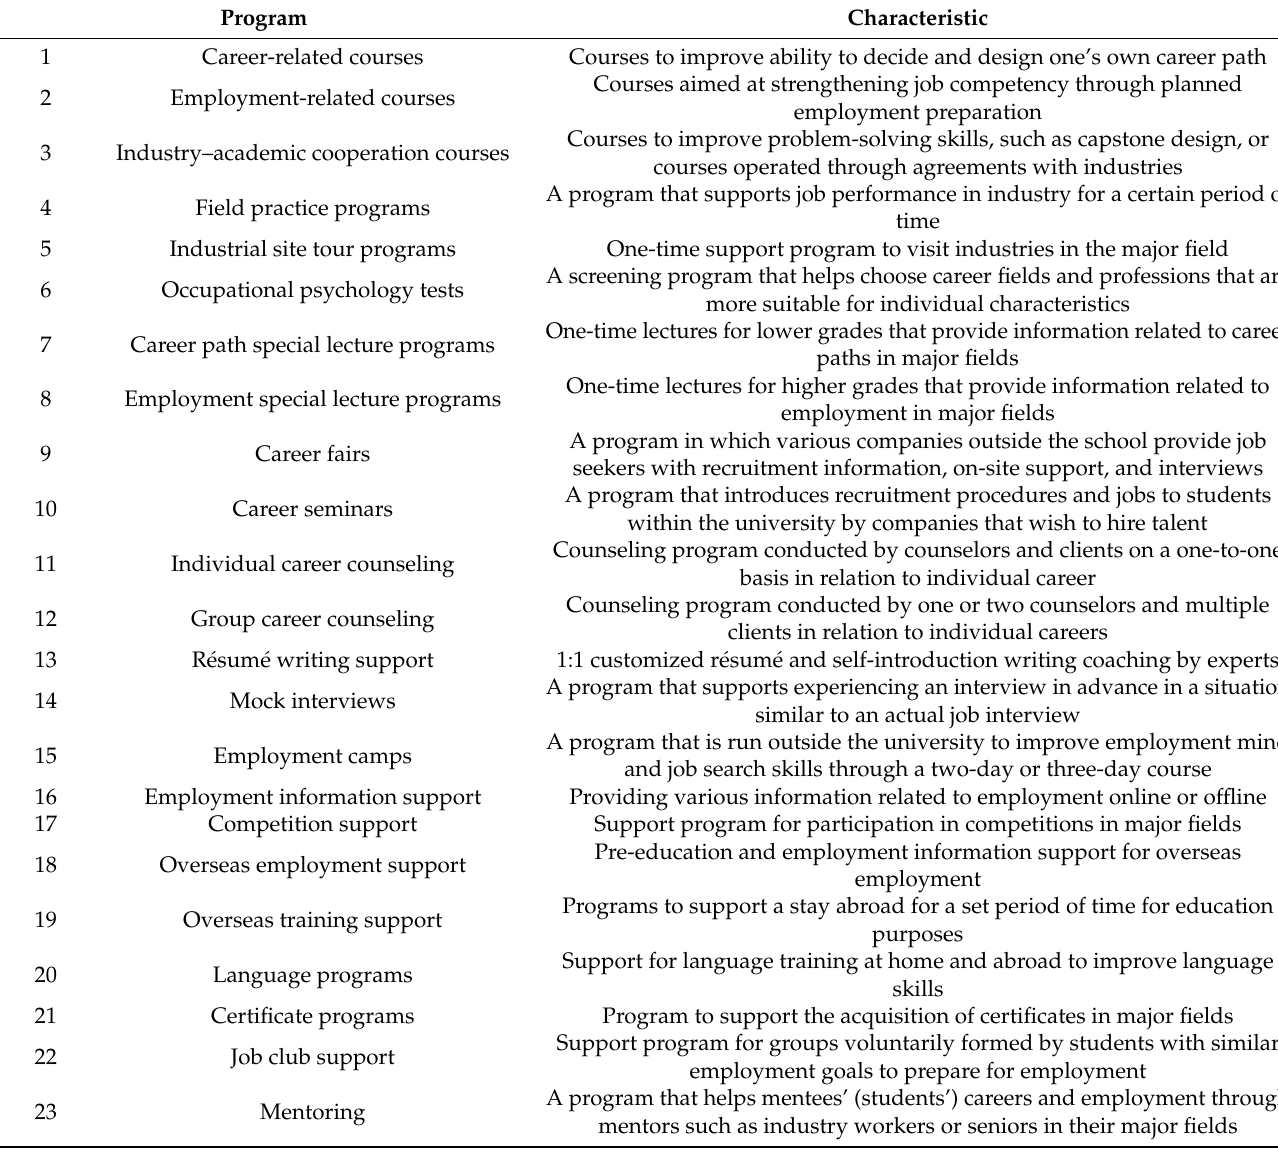
Table 1. Types and characteristics of employment support programs used in the